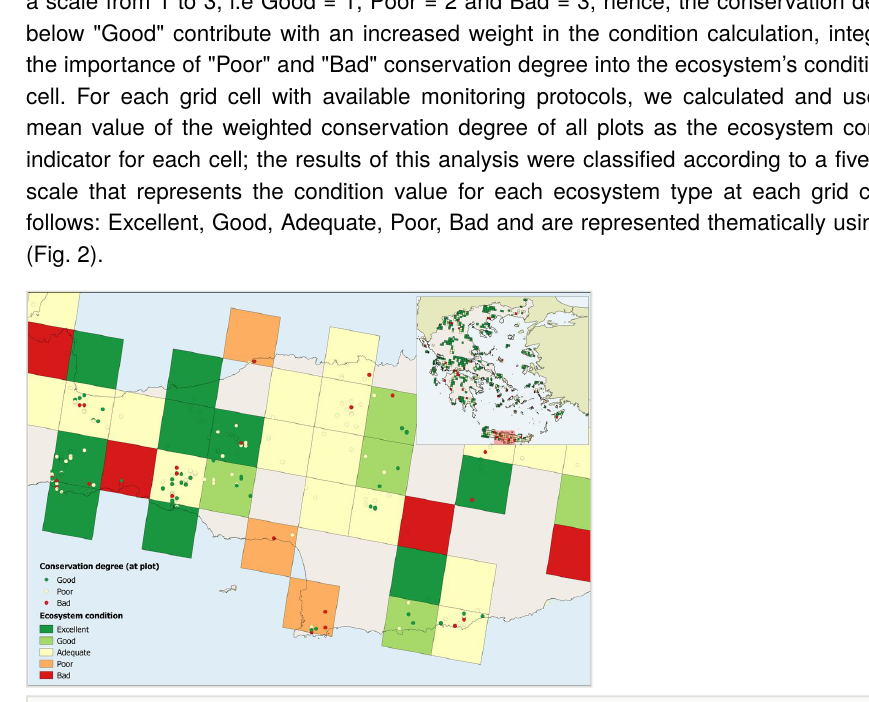
Schematic representation of the methodology used to assess the ecosystem condition in each cell (snapshot from the woodlands and forests assessment). Cell colours represent the ecosystem condition as the mean of all plot values in the